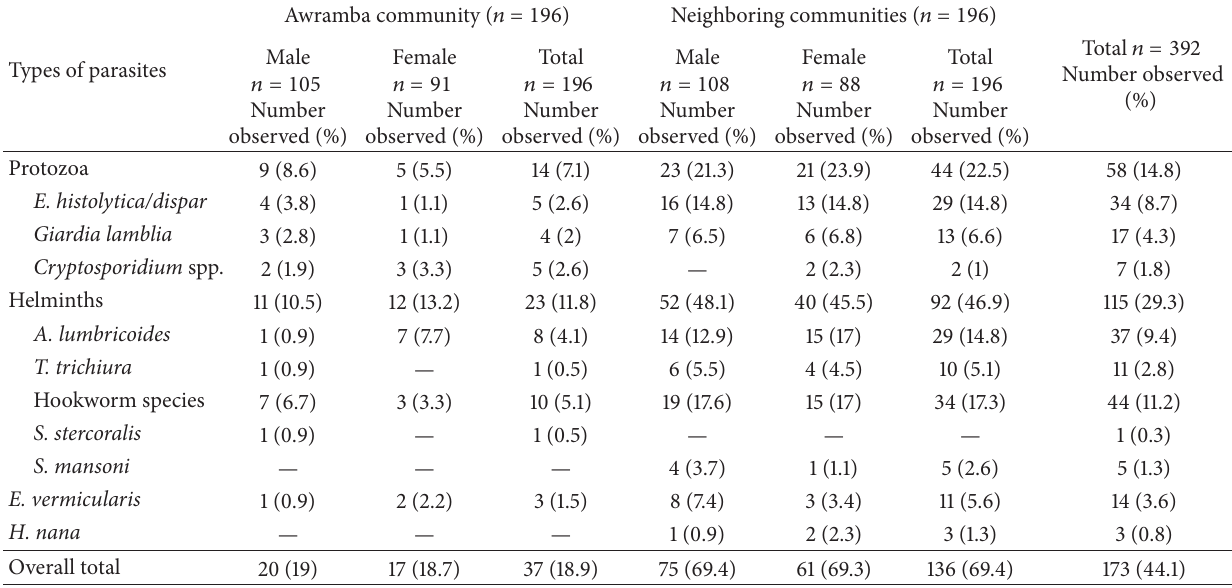
Table1:PrevalenceofintestinalparasitesamongAwrambaanditsneighboringcommunitiesinFogeraWoreda,SouthGondarZone,Ethiopia